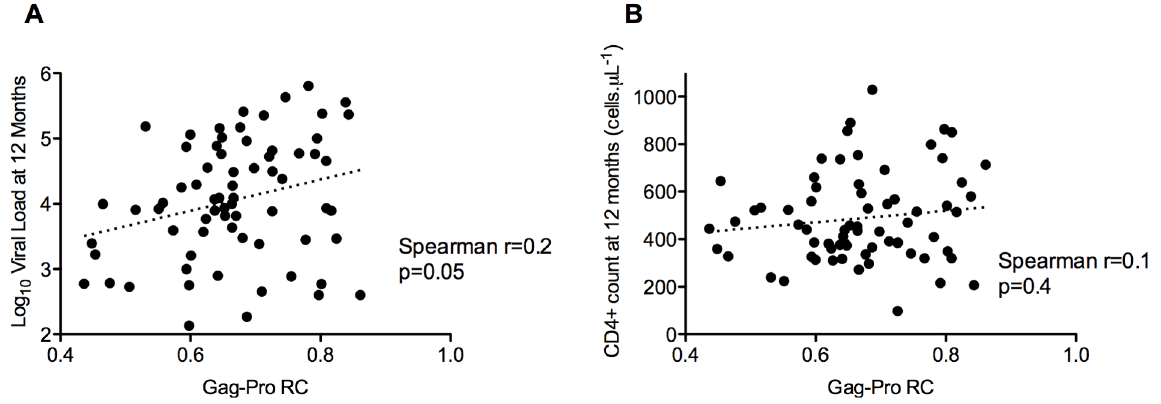
Figure 4. Association between baseline Gag-Protease replication capacity and HIV-1 clinical parameters at 12-months post- infection. A modest correlation was observed between early Gag-Protease-mediated replication capacity and plasma viral load (Spearman, r=0.2, p=0.05; Panel A), but not CD4 + cell count (Spearman, r=0.1, p=0.4; Panel B), at 12 months post-infection.